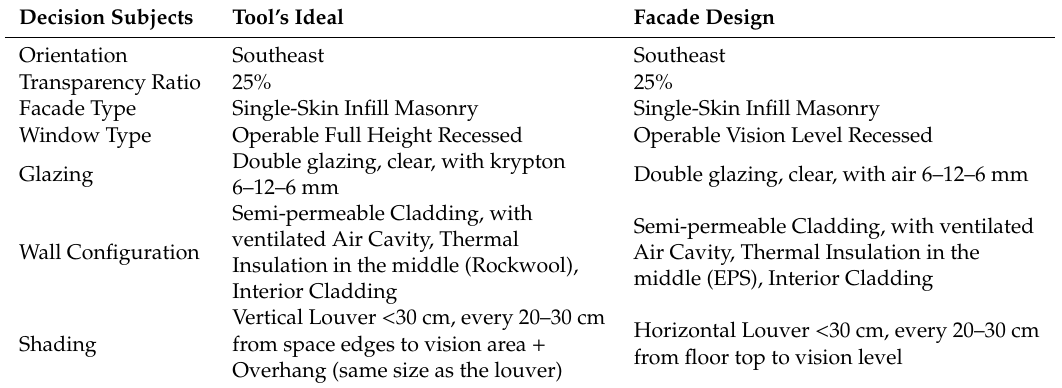
Table 6. Comparison of design decisions for Gaziantep.